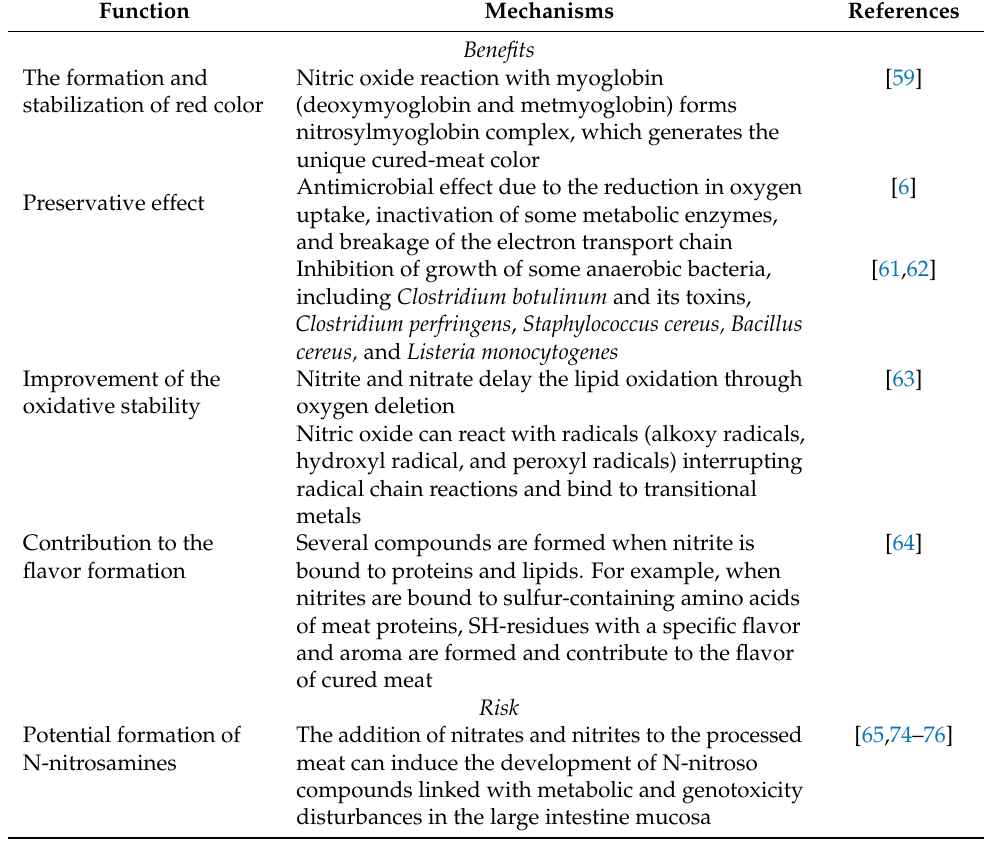
Table 2. The role of nitrates/nitrites in meat